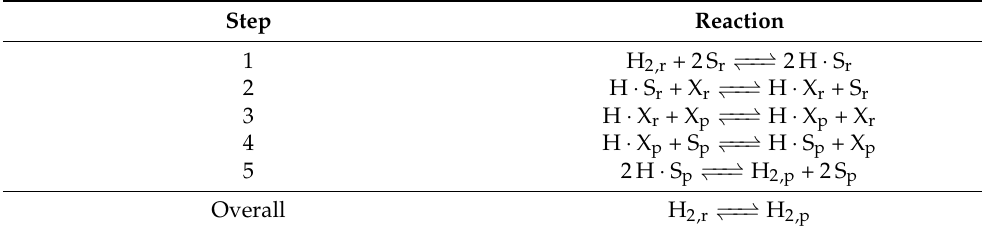
Table 1. Elementary reaction steps of the five-step permeation process [15]. S represents a surface site and X represents a bulk site, while subscripts r and p represent the retentate and permeate side, respectively.